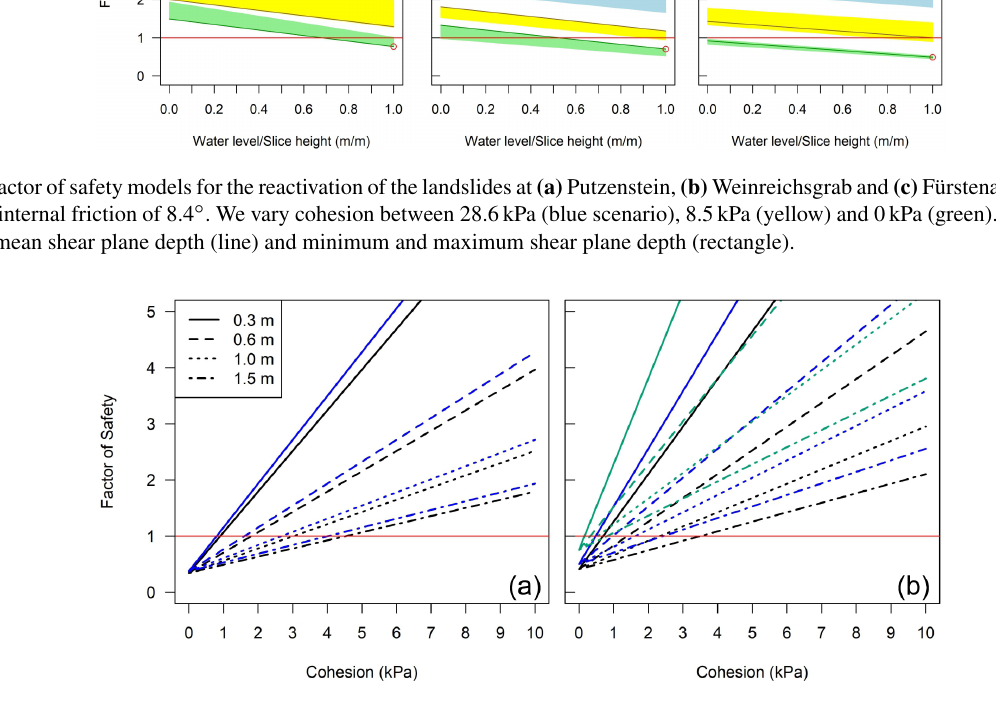
Figure 10. Factor of safety for fully saturated conditions with a residual angle of friction of 8.4 ◦ plotted against cohesion scenarios ranging from no cohesion to 10kPa for (a) translational landslides at road cuts and (b) landslide toes. Line style highlights the depth of shear plane ranging between 0.3 and 1.5m. Line colour in (a) refers to Putzenstein (black) with a slope angle of 13 ◦ and Weinreichsgrab and Fürstenanger (both blue) with slope angles of 12 ◦ . Line colour in (b) refers to Putzenstein (black) with a slope angle of 11 ◦ , Weinreichsgrab (blue) with a slope angle of 9 ◦ and Fürstenanger (green) with a slope angle of 6 ◦